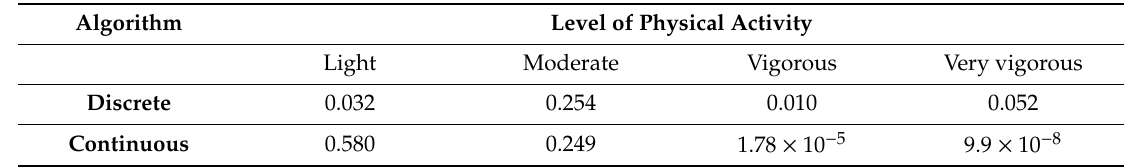
Table 4. Post-hoc results for the activity intensity classification compared to the classification of the commercial solution ( p -value, statistically significant results are in